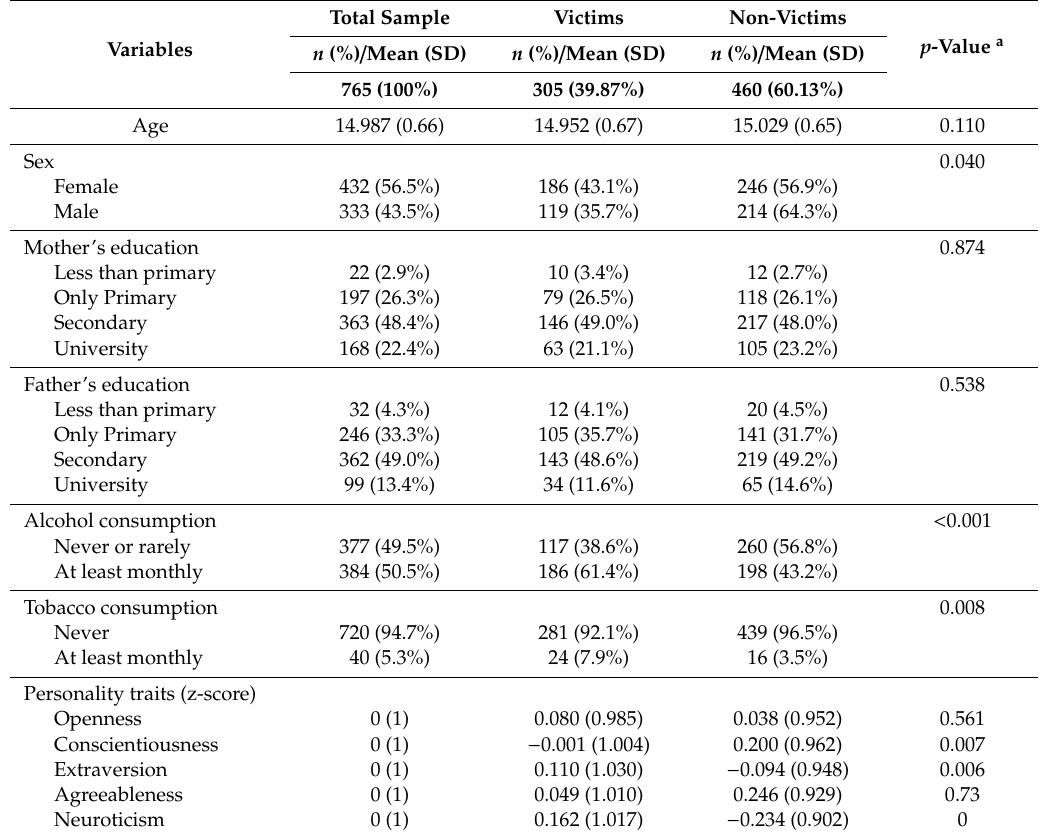
Table 1. Characteristics of students who were and were not victims of